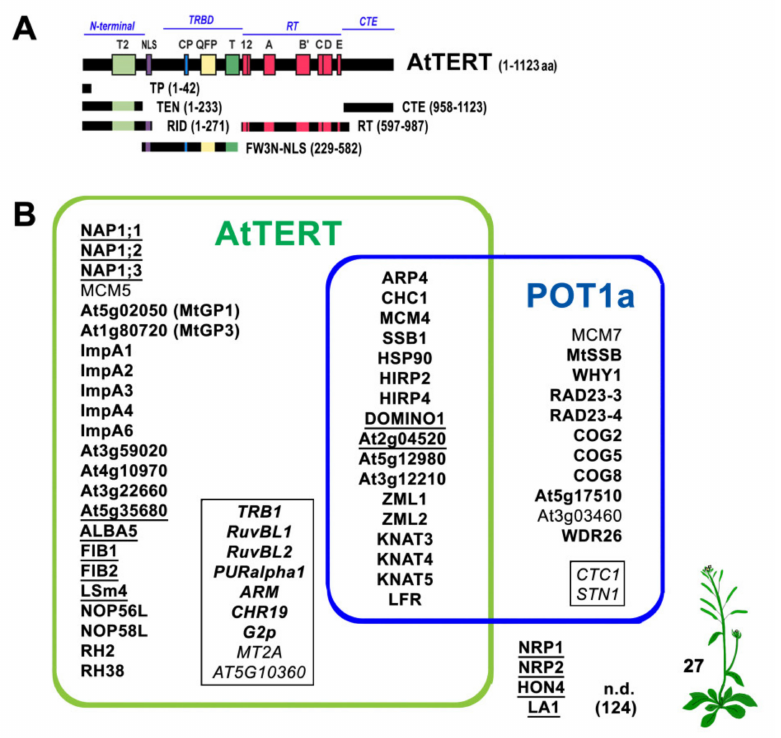
Figure 1. Overview of scientific background and study results. ( A ) AtTERT protein constructs used in this study cover functionally distinct TERT domains and protein motifs, i.e., the telomerase